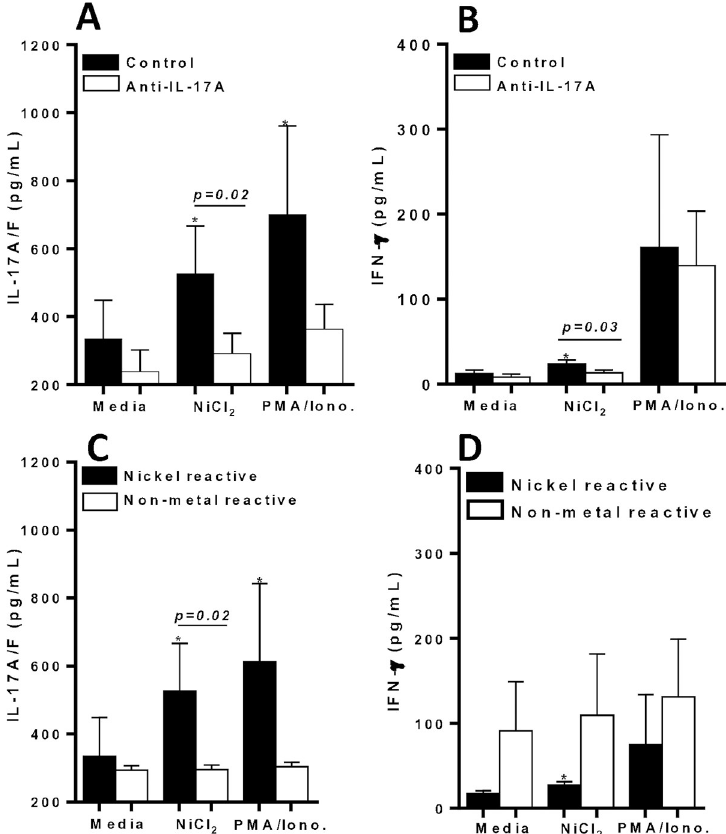
Fig 13. Inhibition of IL-17A signaling mitigates cytokine production in metal-reactive lymphocytes, while non- metal reactive lymphocytes do not exhibit increases in cytokine production compared to metal-reactive individuals in response to metal challenge in vitro . Anti-hIL-17A treatment significantly mitigates cytokine production among metal-reactive individuals’ lymphocytes to metal challenge. Production of (A) IL-17A/F or (B) IFN- γ in the absence/presence of metal challenge and/or anti-hIL-17A from n = 10 metal-reactive individuals, and (C) IL- 17A/F or (D) IFN- γ production in the absence/presence of metal challenge from n = 10 metal reactive individuals’ lymphocytes vs. n = 9 non-metal reactive individuals’ lymphocytes. Data are shown as mean ± SEM. Asterisk ( � ) signifies statistical significance at p � 0.05 compared to respective control group as determined by paired or unpaired Student’s